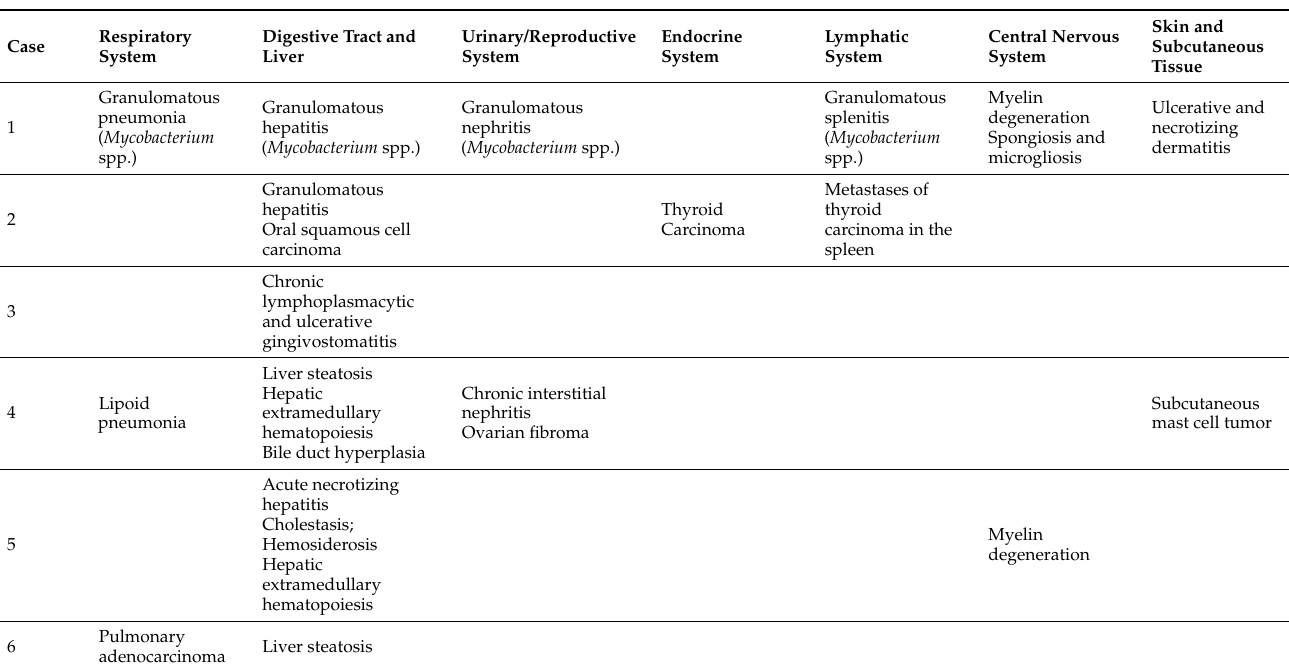
Table 4. Main pathological findings grouped by